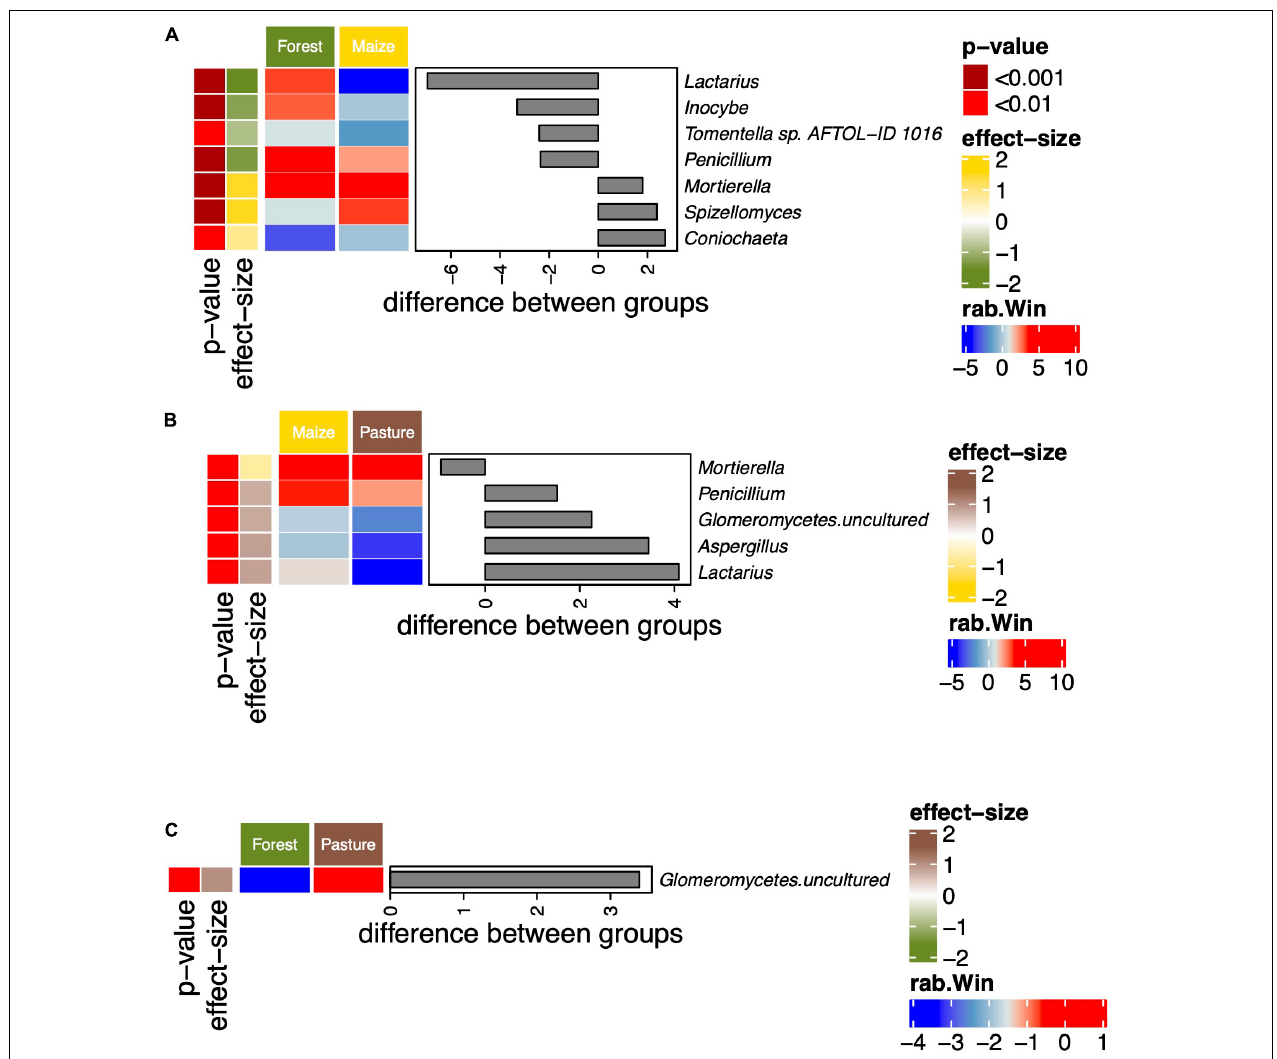
FIGURE 3 | Differentially abundant fungal genera between a coniferous forest soil (Forest), a deforested for grazing (Pasture), and in a maize ( Zea mays L.) cultivated deforested soil (Maize) at the “ Área de Protección de Flora y Fauna Nevado de Toluca ” (Mexico) as determined by an ANOVA-Like Differential Expression tool for compositional data and Benjamini–Hochberg sequential correction. Comparisons between Forest and Maize (A) , Maize and Pasture (B) , and Forest and Pasture (C) fungal